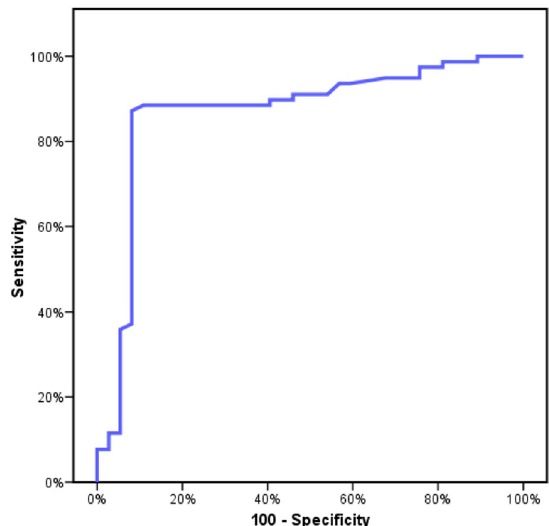
Fig. 1 Receiver Operating Characteristic (ROC) curve for different ARFI measurements showing a best cut off value to identify malignant LN 2.70 m/sec, (Area under the curve:0.819, 95% ≥ confidence interval (CI): 0.744 and